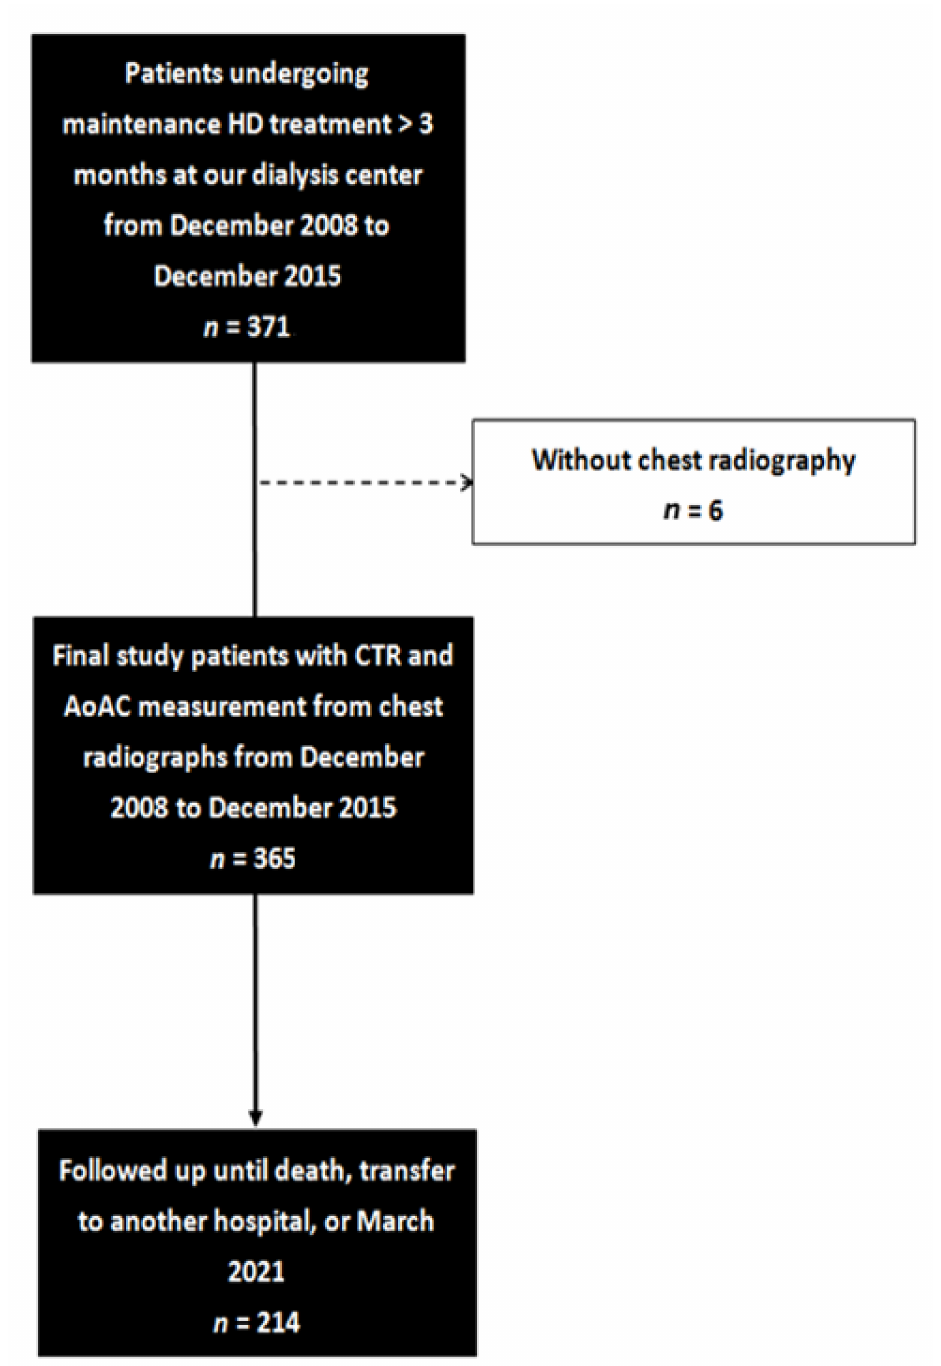
silhouette divided by that of the chest on a chest X-ray. Cardiomegaly was defined as a CTR > 50%.